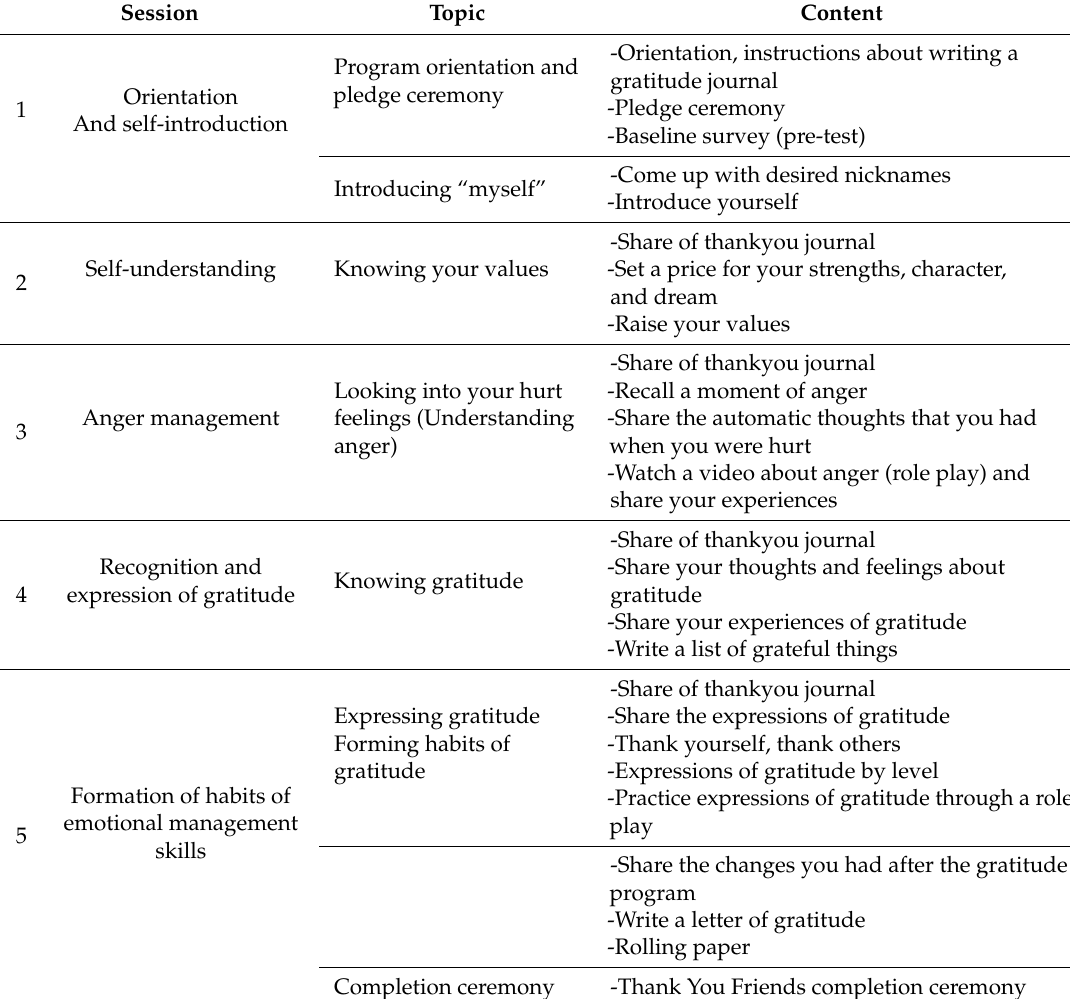
Table 1. Emotion management program for late adolescent male